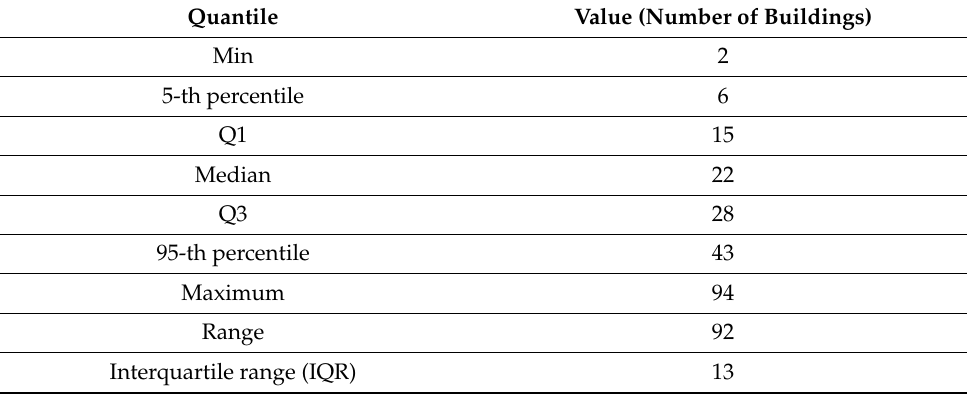
Table 5. Quantile of the number of buildings according to the years of use of public